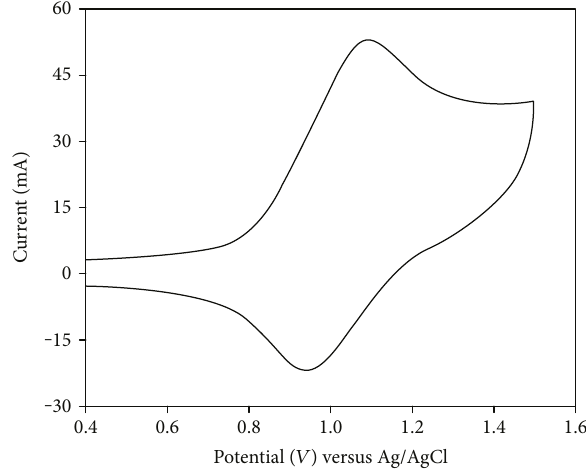
Figure 3: Cyclic voltammogram of adsorbed CL1 dye at a scan rate of 100 mV/s, in 0.1M TBAPF in acetonitrile showing 6 quasi-reversible behaviour; the oxidation and reduction peaks can be attributed to the triphenylamine moieties and cyanoacrylic acid, respectively.